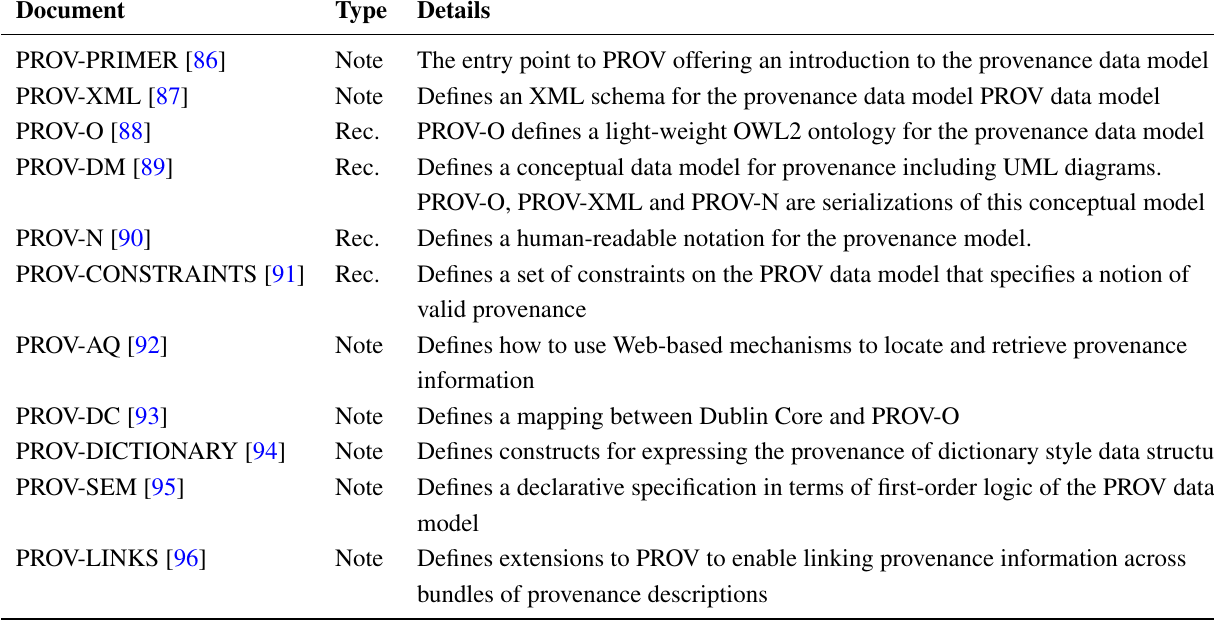
Table 6. PROV documents description. Document type (Recommendation or Note) is also shown.